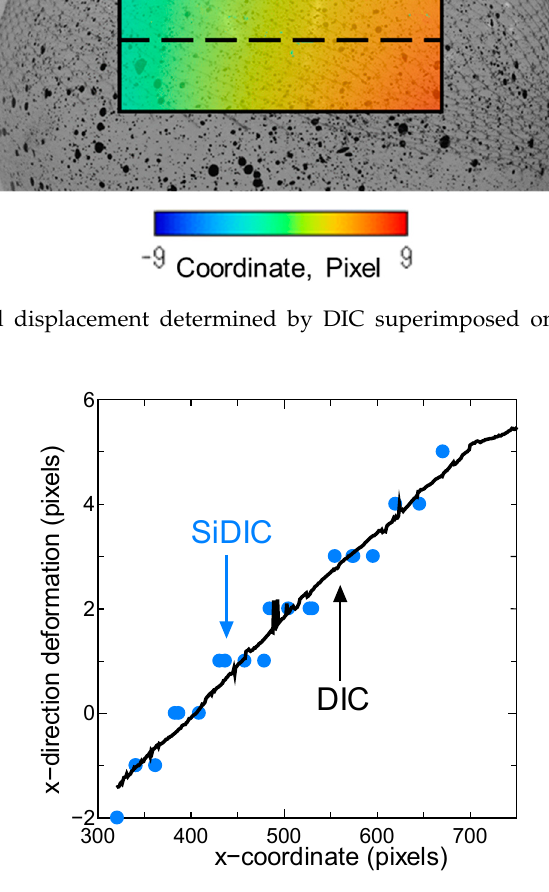
Figure 7. Comparison of horizontal displacement distributions obtained by DIC and SiDIC for the control path highlighted in Figure 6.